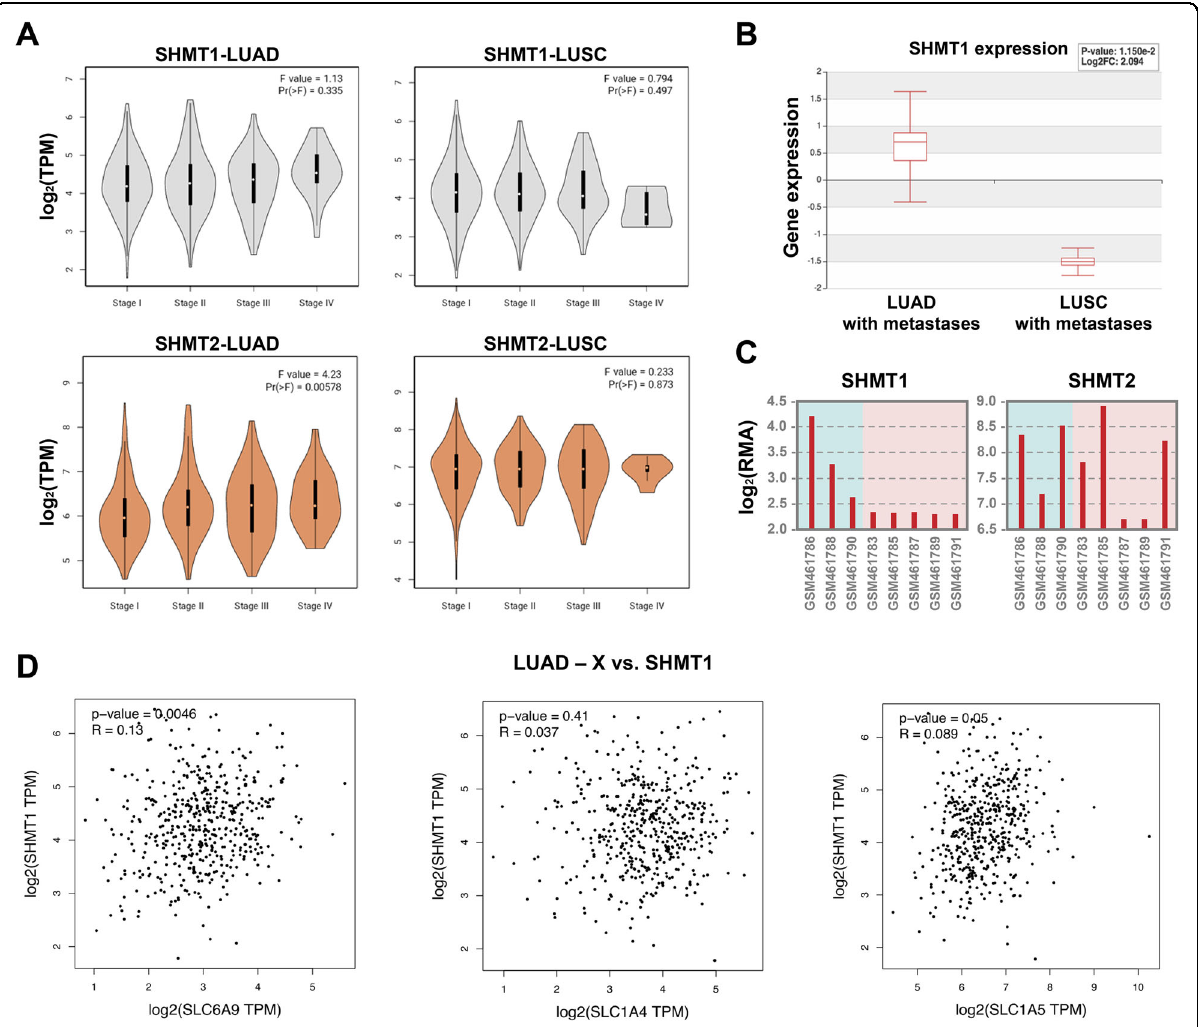
Fig. 4 Shmt1 and shmt2 expression in patients during lung cancer progression. A Analysis of shmt1 and shmt2 related to patient pathological stage represented with the violin plots, Log2 (TPM + 1) for log scale. B shmt1 and shmt2 gene expression in lung adenocarcinoma with metastasis vs. lung squamous cell carcinoma with metastasis. C shmt1 and shmt2 gene expression in metastatic sites of different tumors from GSE18549 series 45 . Data are expressed as log2 RMA signal intensity. GSM461786, GSM461788, GSM461790, lung adenocarcinoma (primary site) to brain (metastatic site); GSM461783, breast carcinoma to brain; GSM461785, colon adenocarcinoma to brain; GSM461787, esophageal adenocarcinoma to brain; GSM461789, colorectal adenocarcinoma to brain; GSM461791, breast mucinous adenocarcinoma to brain. D Pearson correlation analysis of SHMT1 as log2(TPM) and of SLC6A9, SLC1A4 and SLC1A5 in Lung adenocarcinoma (LUAD). P value cutoff = 0.001. Data from TGCA and GTEx. One-way ANOVA and Student ’ s t test were used for statistical analysis (ns = not signi fi cant; * P < 0.05; ** P < 0.01; *** P <